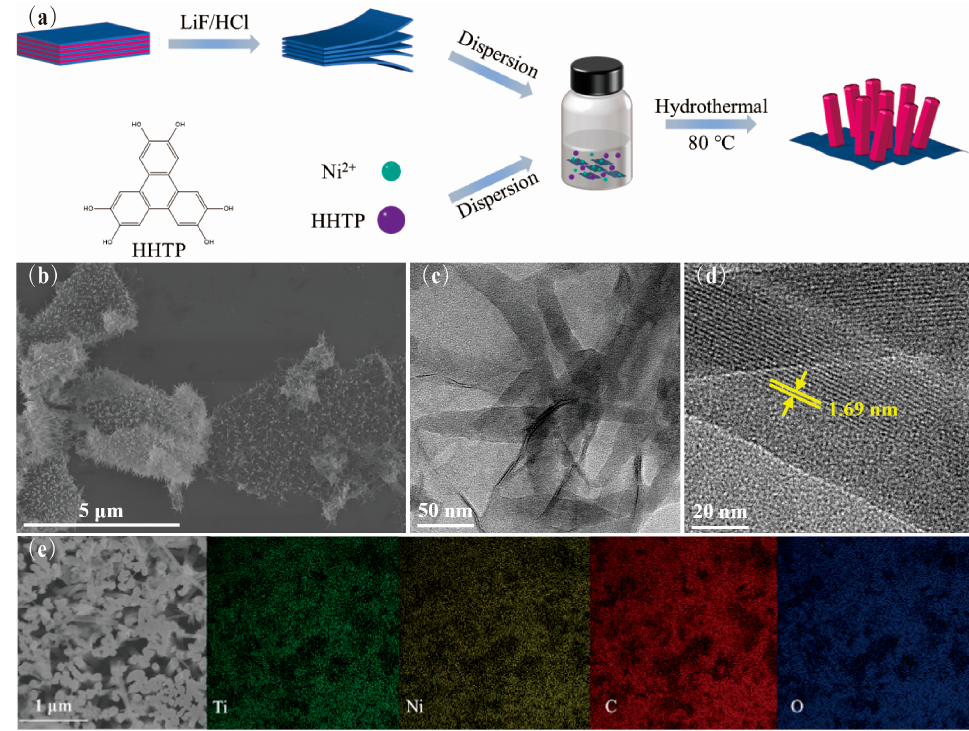
Figure 1. ( a ) Schematic illustration of the synthesis of Ni-MOF/Ti 3 C 2 T x sample; ( b ) SEM image of Ni-MOF/Ti 3 C 2 T x ; ( c ) TEM image of Ni-MOF/Ti 3 C 2 T x ; ( d ) HRTEM image of Ni-MOF nanorods; and ( e ) EDS mapping of Ni-MOF/Ti 3 C 2 T x .